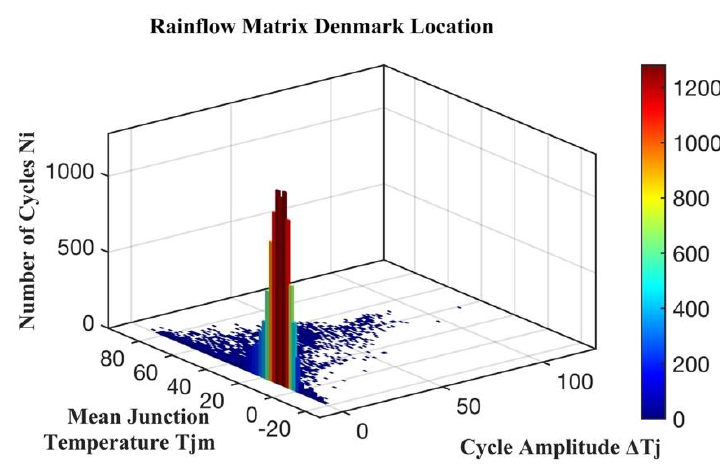
Figure 10. Rainflow matrix at the location in Denmark.